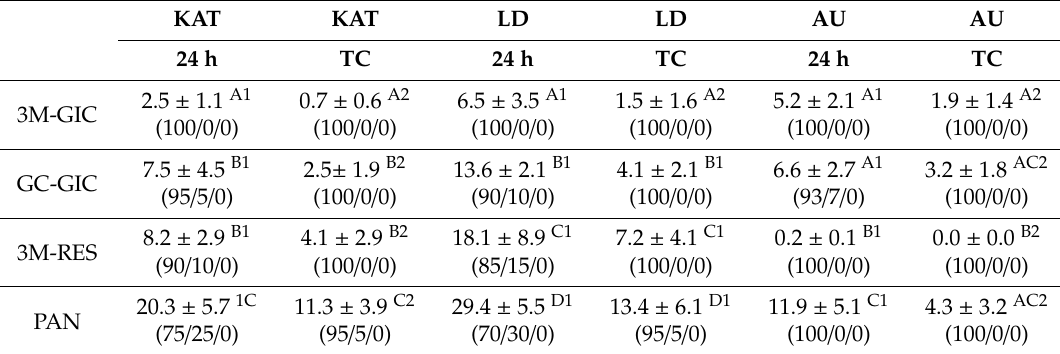
Table 1. Mean ± SD of the SBS (MPa) at 24 h and after thermocycling (TC) of the tested cements to different substrates (KAT: zirconia; LD: Lithium disilicate; AU: gold alloy). Failure pattern is represented as percentual (adhesive/mix/cohesive).